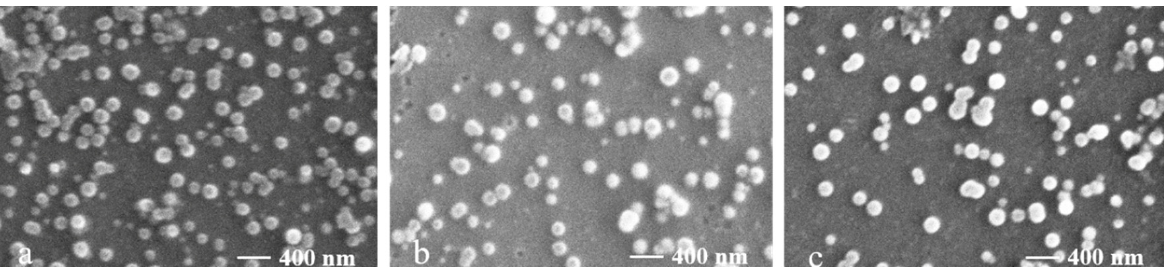
Figure 4. SEM spectra of the SFP nanomicelles. Scale bar: 400 nm. ( a ) SFP-C12M; ( b ) SFP-C14M; ( c ) SFP-C16M.